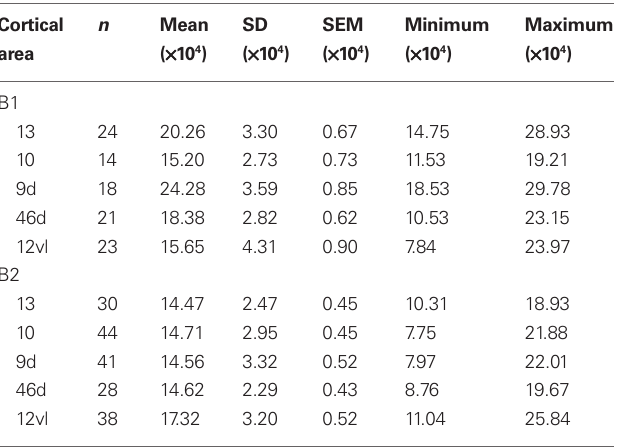
Table 12 | Size of the cell bodies of layer iii pyramidal cells (in the tangential plane) in the baboon gPFC.